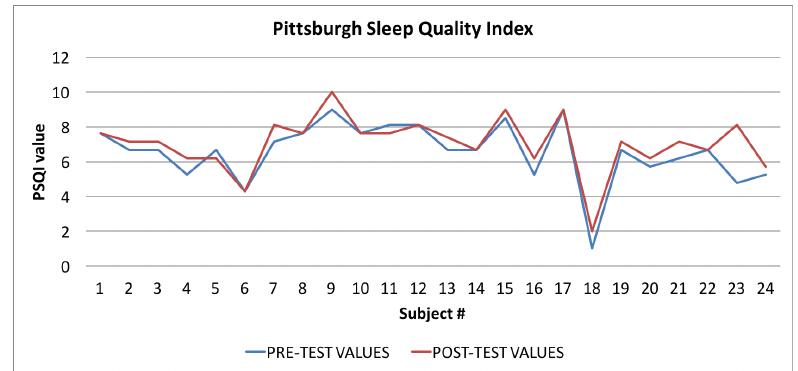
Figure 12. Pittsburgh Sleep Quality Index: averages of the values calculated at the beginning (blue line) and at the end of the trial (red